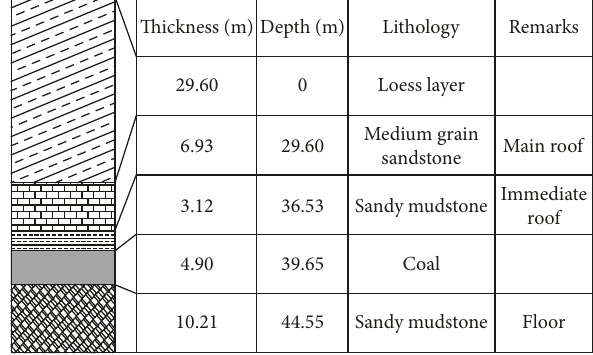
Figure 2: Stratigraphy of the coal rock